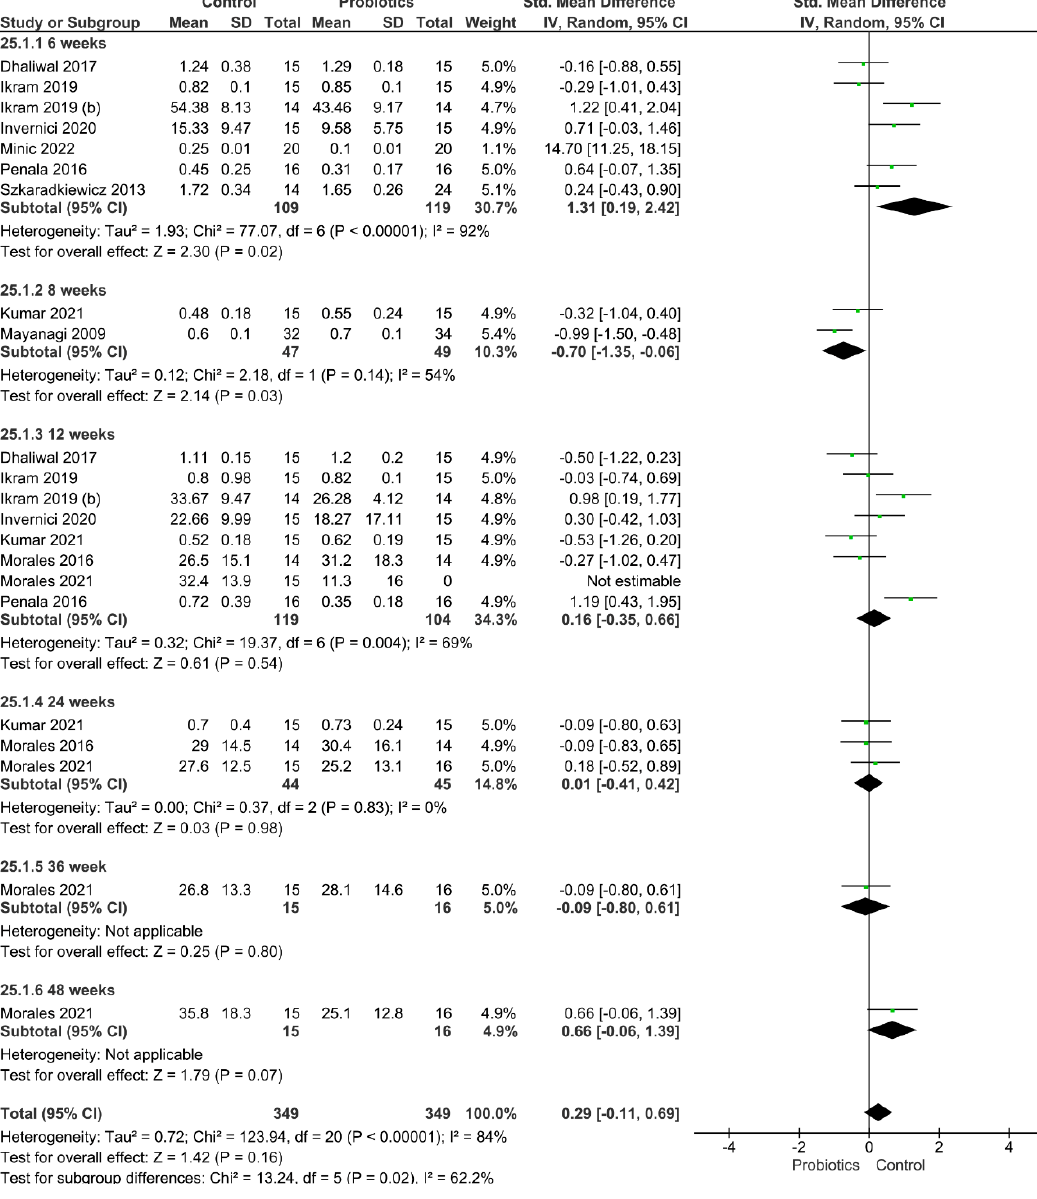
Figure 2. Results from the meta-analysis for the index plaque clinical parameter.